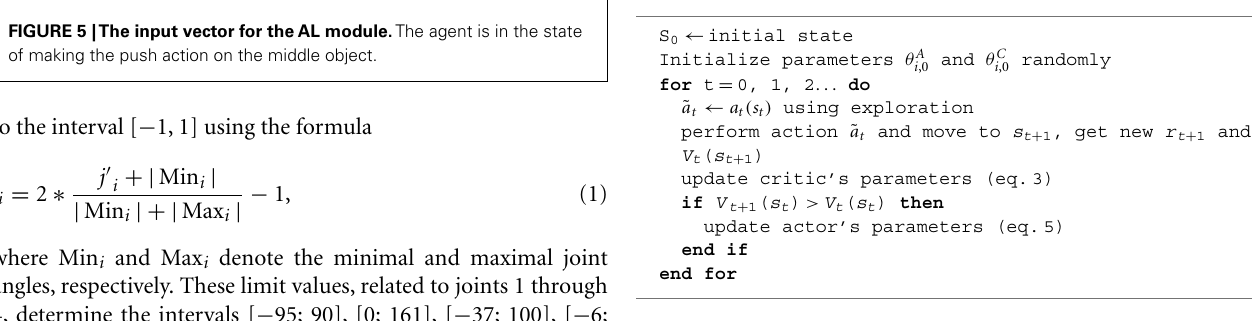
Algorithm 1: CACLA learning